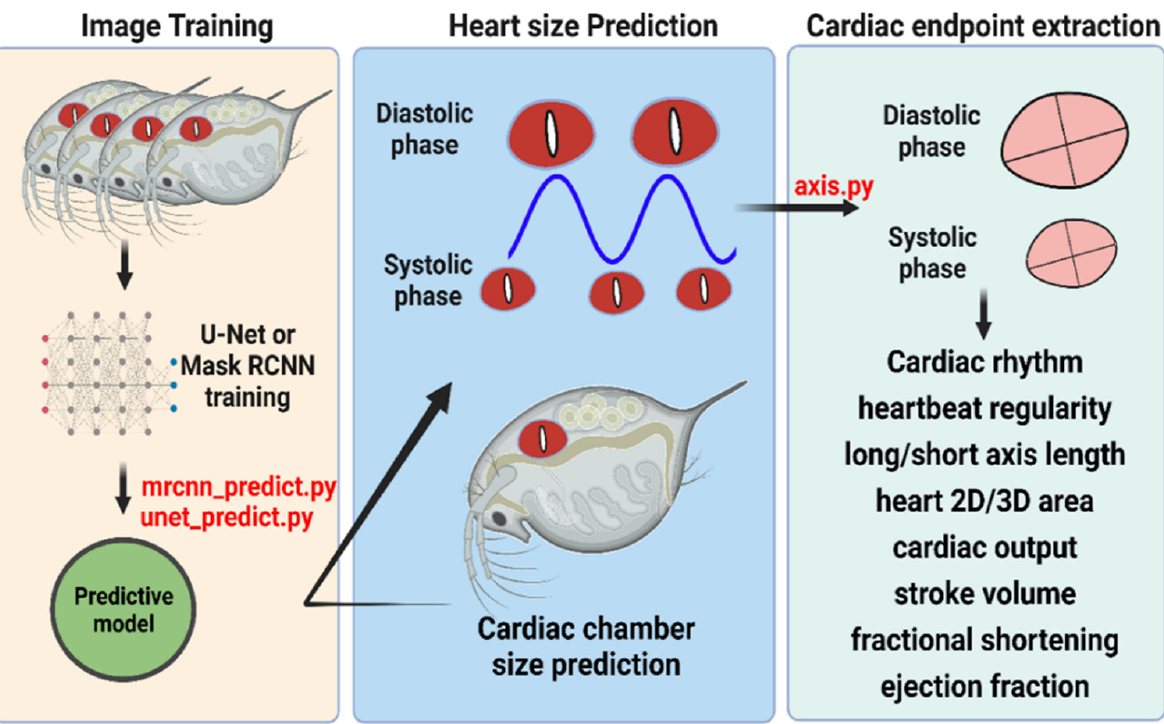
Figure 1. Experimental workflow for water flea heart size prediction by using a deep learning ap- proach. Two different convolutional networks of U-Net and Mask RCNN were used for comparison.